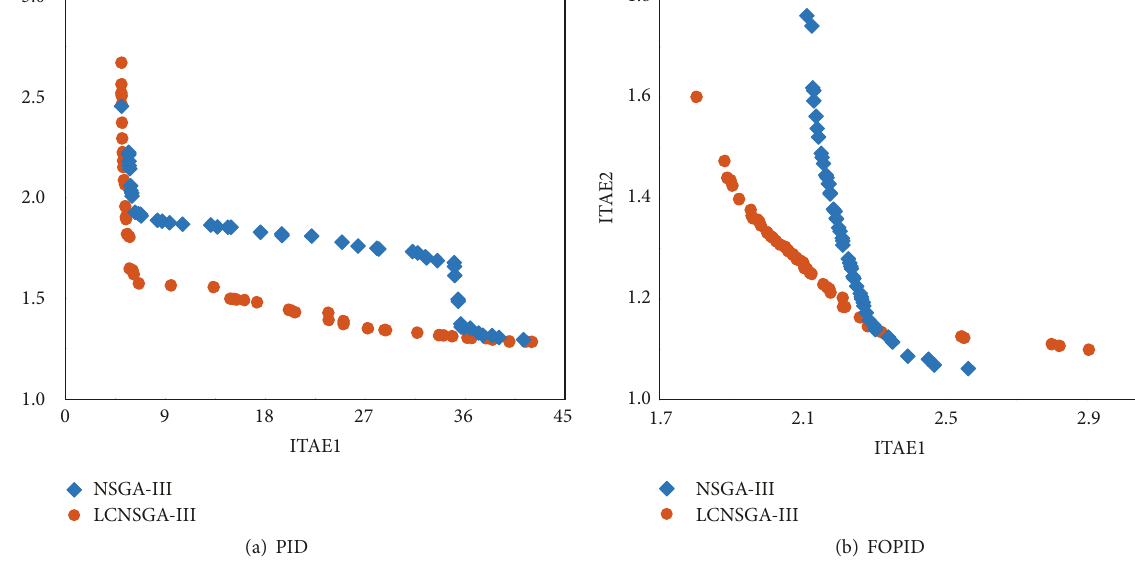
conditions. Implementation of the MO-FOPID